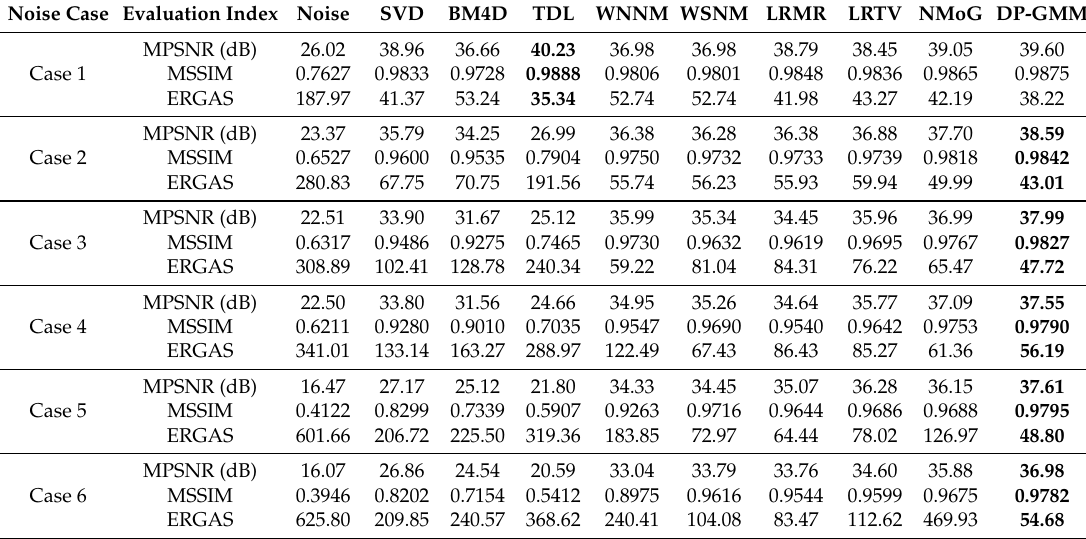
Table 1. Quantitative Evaluation of different methods on the simulated DC Mall dataset in different cases of noise.